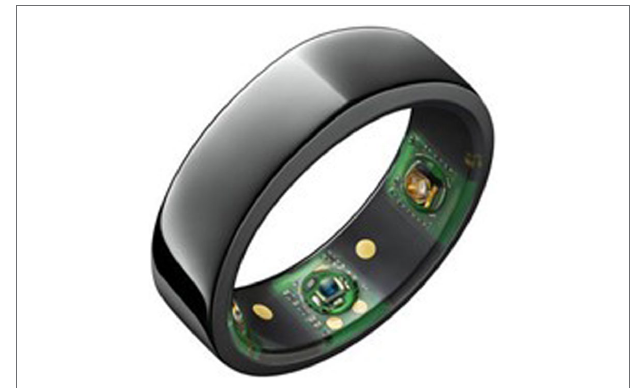
FIGURE 2 | Commercially available multisensory wearable sleep and activity tracker (Oura ring 2nd generation; Oura Health, Oulu, Finland) highlighting sensor